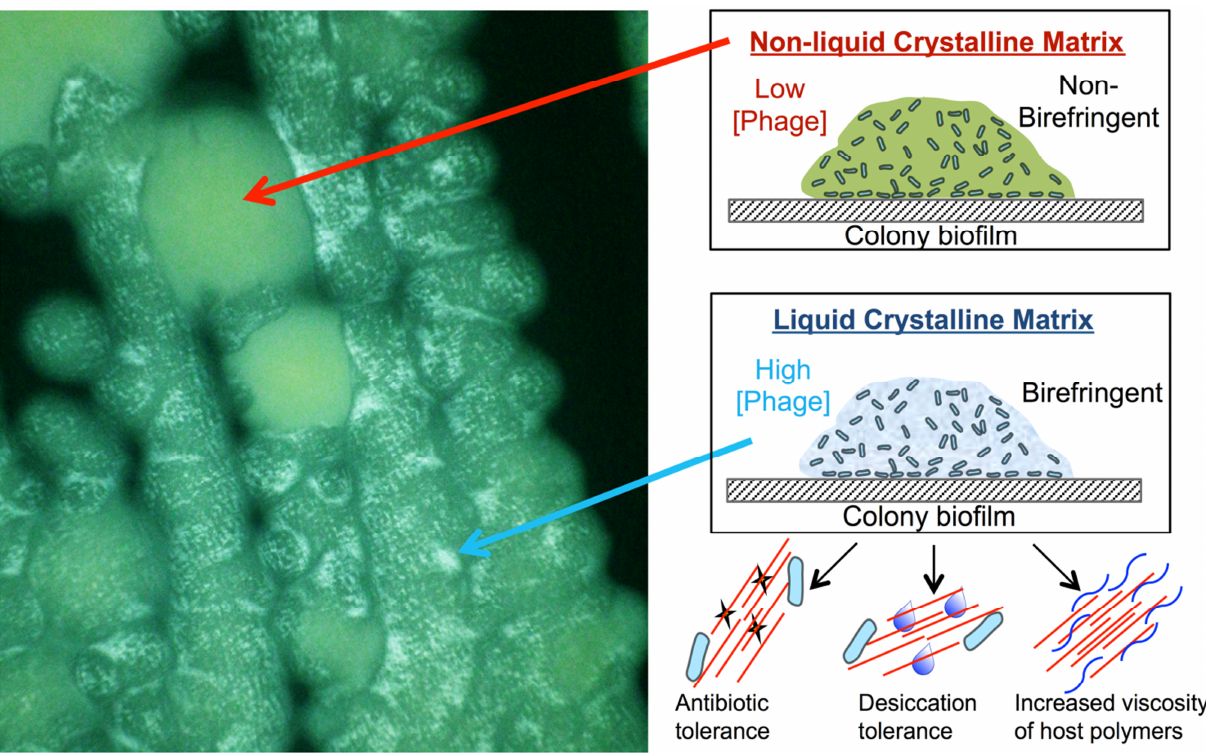
FIGURE 2: Pf phages organize the P. aeruginosa biofilm matrix into a liquid crystal. The birefringence of the liquid crystalline biofilm matrix can be visualized by placing colony biofilms on an agar pad between crossed polarizing lenses. The liquid crystalline matrix can change the polarization of light allowing it to pass through both polarizing lenses. Thus, non-liquid crystalline biofilms appear opaque (red arrow) while liquid crystalline biofilms appear bright (blue arrow). The organization of the biofilm matrix into a liquid crystal enhances adhesion, antibiotic tolerance, and desiccation survival. Further, Pf phage can increase the viscosity of host polymers such as mucin and